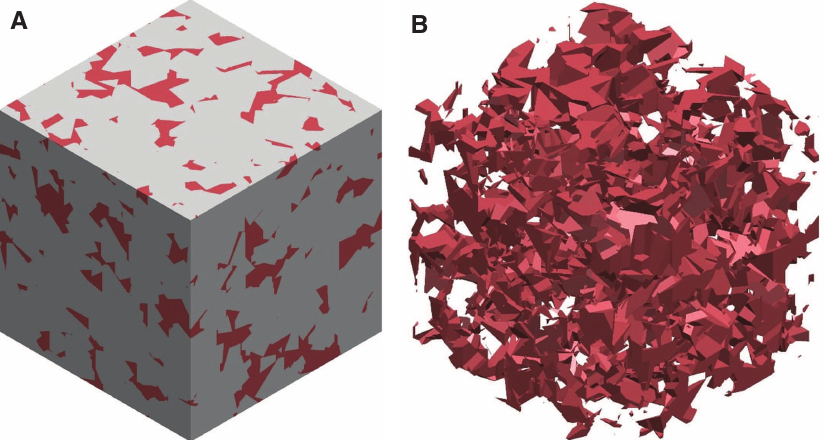
Figure 5: Three-dimensional microgeometry containing 9% Co and cobalt islands: (A) isometric view and (B) detailed view on the cobalt phase.